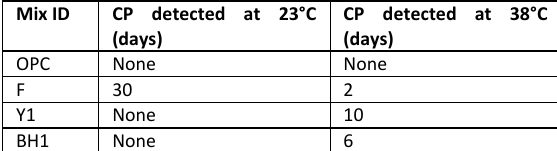
Table 1. Results of slope change ‐ point detection on processed SR data at 23°C and 38°C. None indicates that no slope change ‐ point was